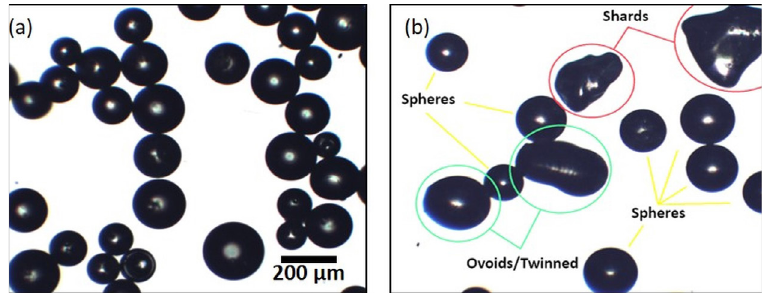
Figure 2. Images of the produced microspheres from RHA glass: (a) microspheres and, (b) other typical generated